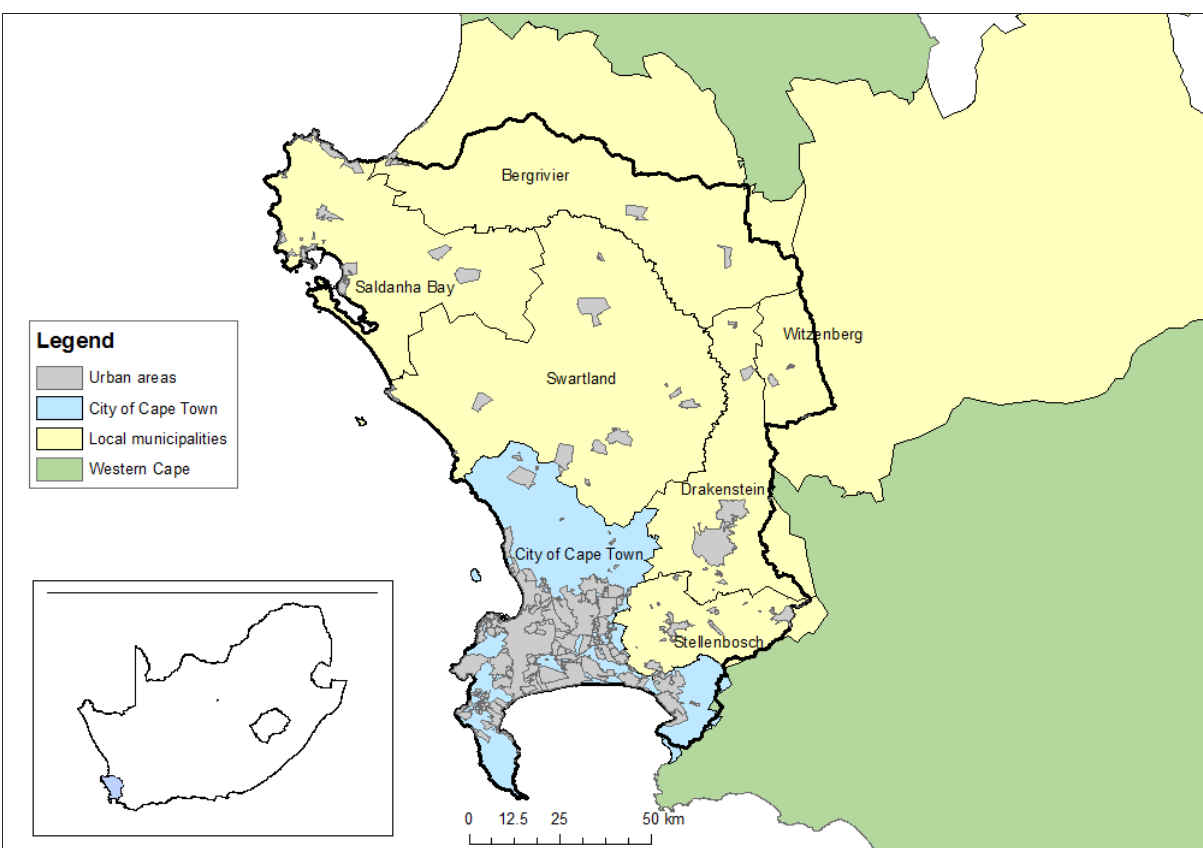
Figure 2: Urban areas, local municipalities and the City of Cape Town within the Berg Water Management